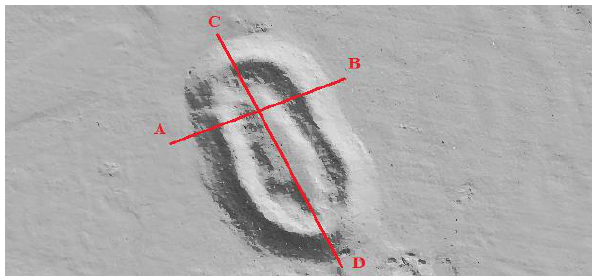
Figure 14. Object 1 - known settlement – location of profiles A- B and C-D with shaded DTM Above the longitudinal profiles A-B and C-D are presented (Figure 14). Profiles allowed to identify the highest places in relation to the surrounding area.